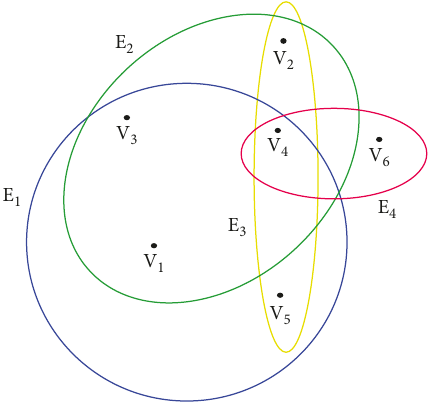
Figure 5: Independent set S of IFHG H .